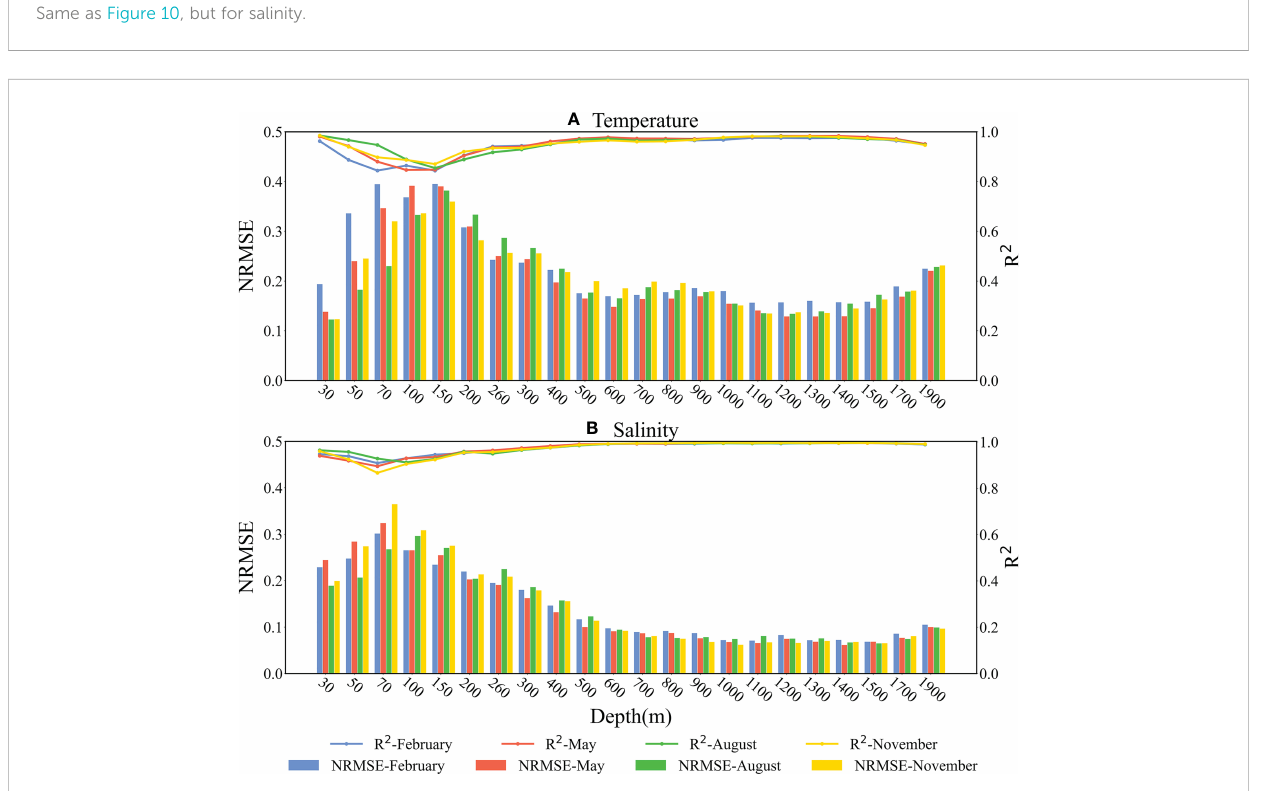
FIGURE 12 Seasonal performance of the CBAM-CNN model for ocean subsurface thermohaline structures estimation at different depths in the tropical Indian Ocean in 2020. Blue indicates February (winter), red indicates May (spring), green indicates August (summer), yellow indicates November(autumn), the histograms display the NRMSE, and the lines display R 2 . (A) for temperature, (B) for